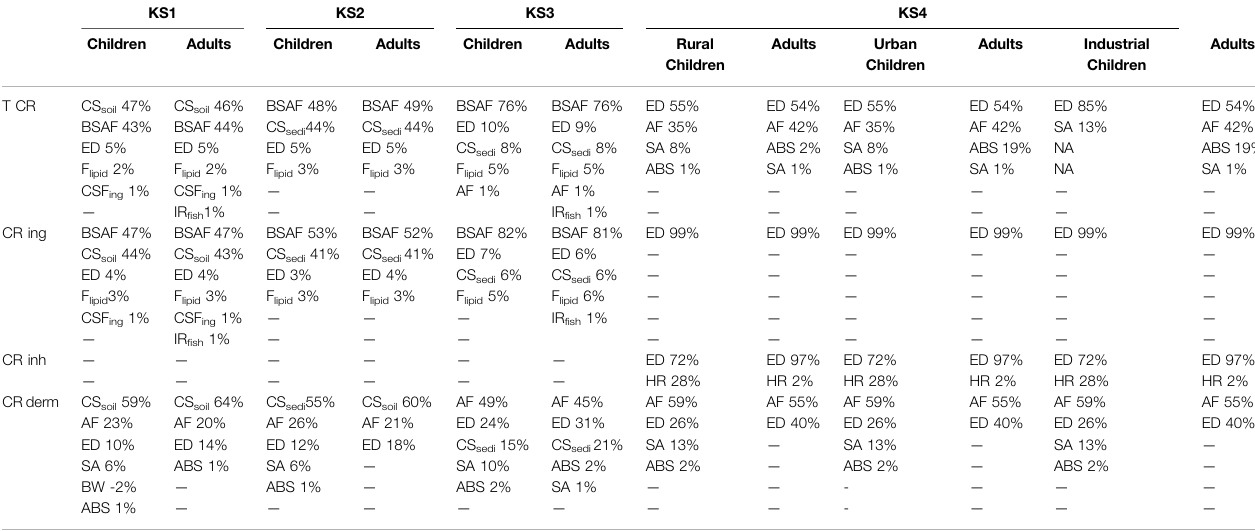
TABLE 4 | Monte Carlo sensitivity test results.